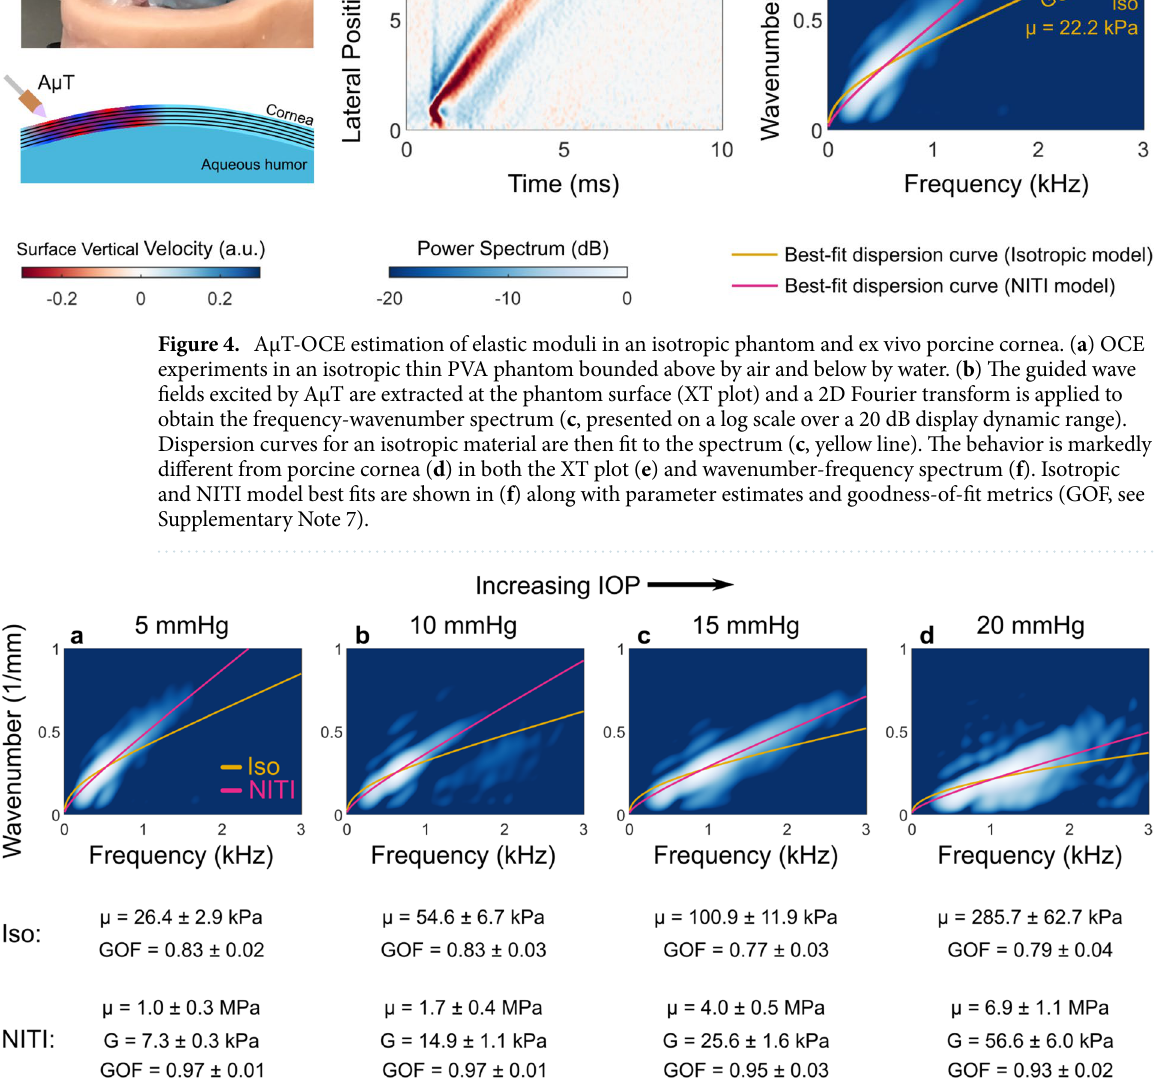
Figure 5. 2D Fourier spectra of wave fields generated and tracked with AμT-OCE along the surface of ex vivo porcine cornea at varying intraocular pressure (IOP). At each IOP, the NITI model (pink line) more closely matches the mode behavior compared to the isotropic model (yellow line). Spectra are shown on a log scale over a 20-dB dynamic range at 5 mmHg IOP ( a ), 10 mmHg IOP ( b ), 15 mmHg IOP ( c ), and 20 mmHg IOP ( d ). Parameter estimates and goodness-of-fit (GOF) metrics (mean ± standard deviation, calculated over repeated OCE measurements for a given cornea/IOP) for each model are shown below their corresponding